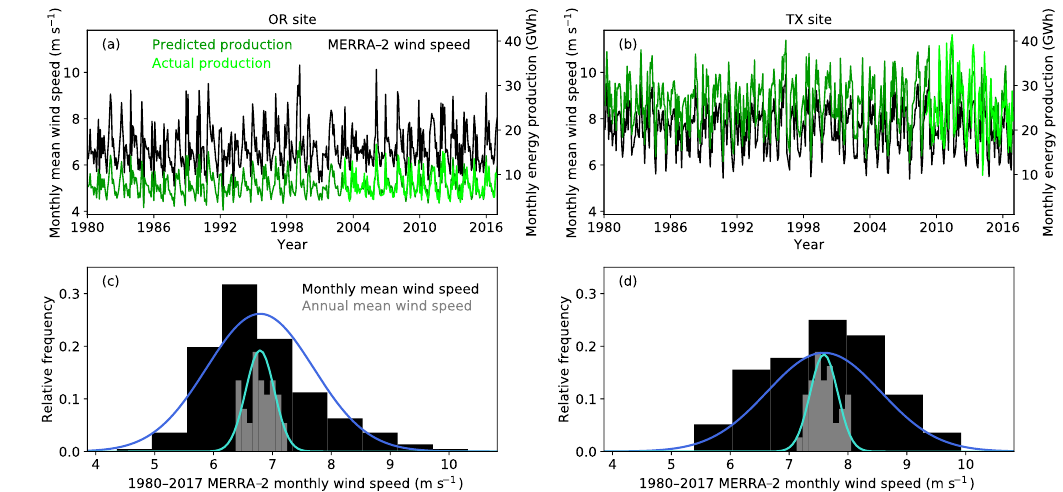
Figure 3. (a) Time series of MERRA-2 monthly mean 80m wind speed (black), actual monthly net EIA energy production (lime), and extended monthly energy production from 1980 to 2016 based on linear regression (green) at the OR site; (b) time series at the TX site with the same annotations as in (a) ; (c) histograms of MERRA-2 monthly mean wind-speed distribution (black) and yearly mean wind-speed distribution (grey) at the OR site from 1980 to 2016. The blue curve indicates the Gaussian fit of the monthly mean wind speeds via the mean and the σ , and the cyan curve represents the Gaussian fit of the annual-mean data; (d) histograms and curves of the Gaussian fit of wind-speed distributions at the TX site with the same annotations as in (c)